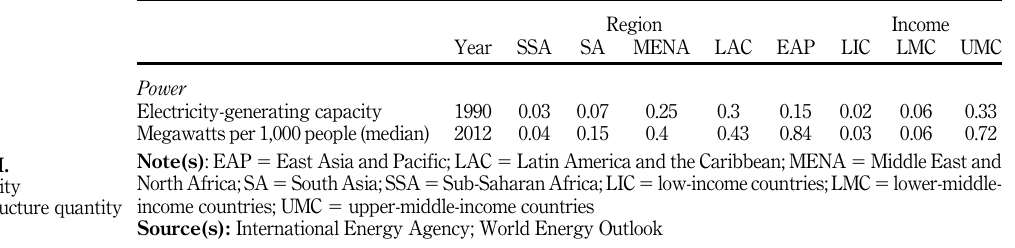
Table I. Electricity infrastructure quantity